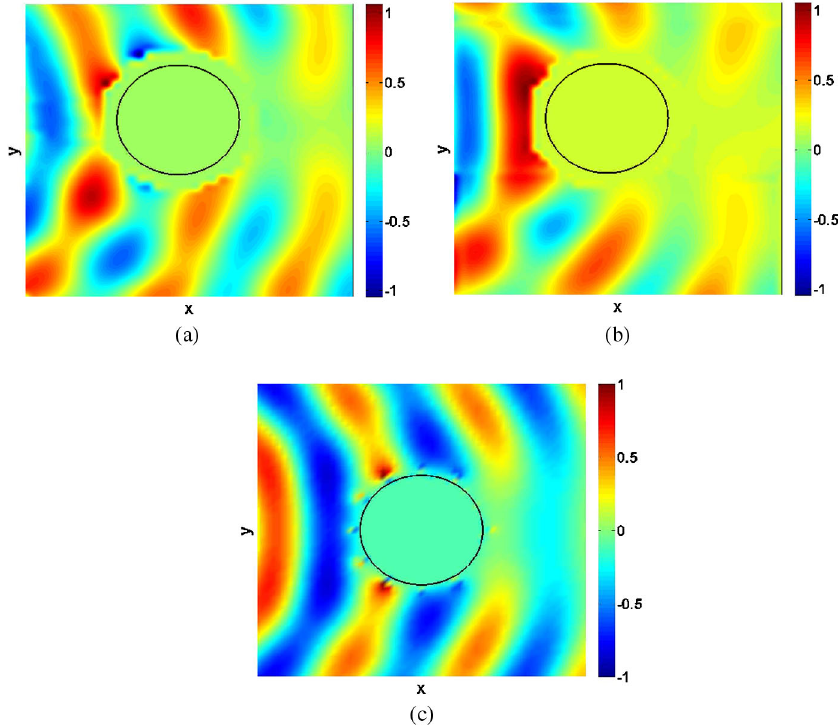
FIG. 11. (a) The measured real part of the total electric field, with the weights of the magnetic-dipole array set up to disguise the cylinder as a smaller metallic cylinder. Note how the shadow region narrows. (b) The measured real part of the total electric field of the bare aluminum cylinder [repeated from Fig. 4(a) for ease of comparison]. (c) The simulated electric field found using COMSOL for disguising a PEC cylinder as a smaller PEC